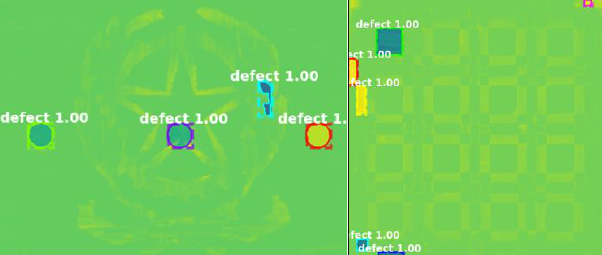
Figure 6. Segmentation results of pulsed thermograms of marquetry samples using Mask R-CNN (Reprinted with permission from Ref. [58]. Copyright: 2021 Garrido, I.; Erazo-Aux, J.; Lagüela, S.; Sfarra, S.; Ibarra- Castanedo, C.; Pivarčiová, E.; Gargiulo, G.; M aldague, X.; Arias, P.).